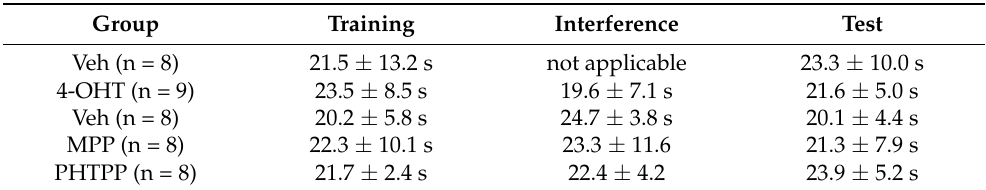
Table 2. Exploration time during training, interference, and test, relative to Figure 2. Veh: vehicle; 4-OHT: 4-hydroxytamoxifen; PHTPP: ER antagonist; MPP: ER antagonist.